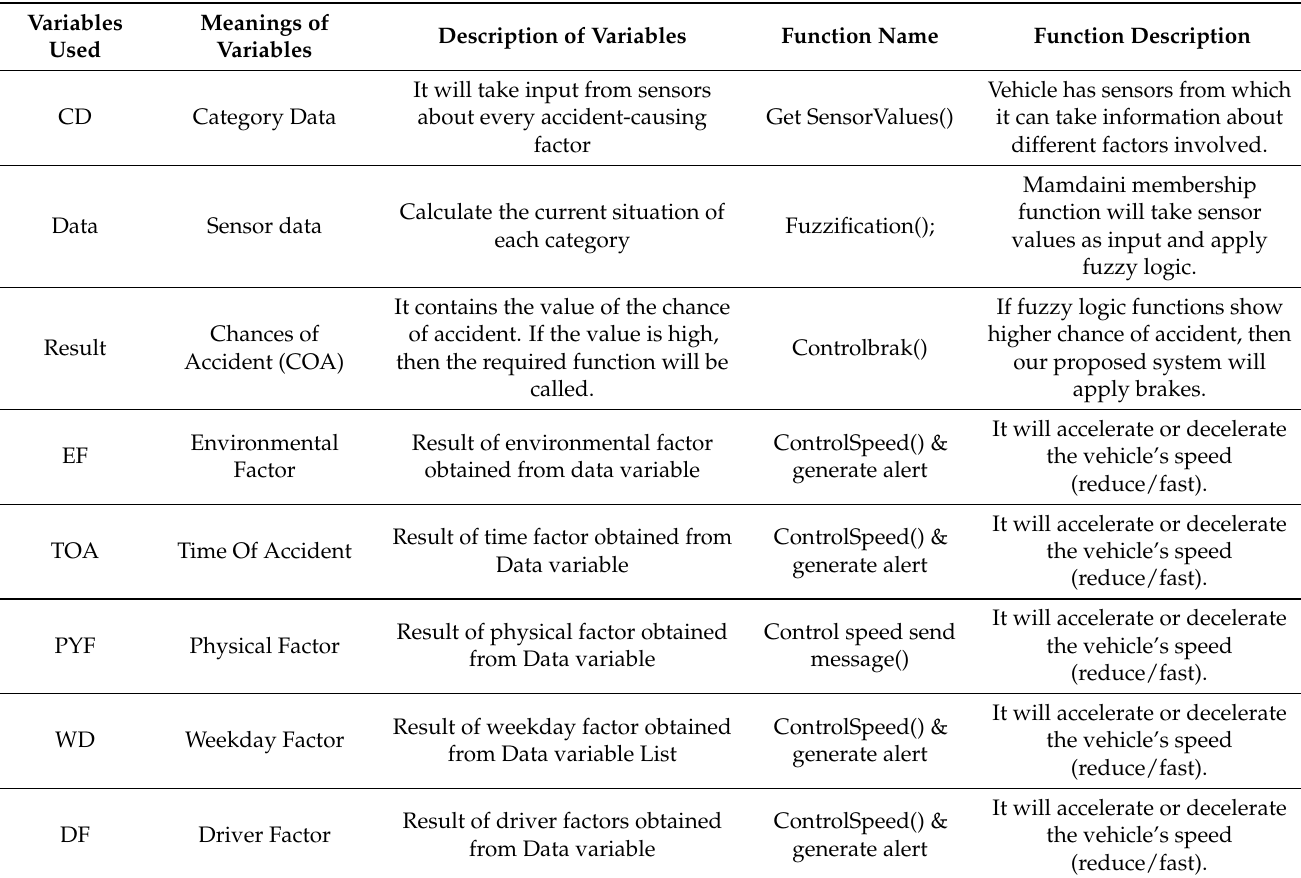
Table 2. Proposed algorithm Variables &